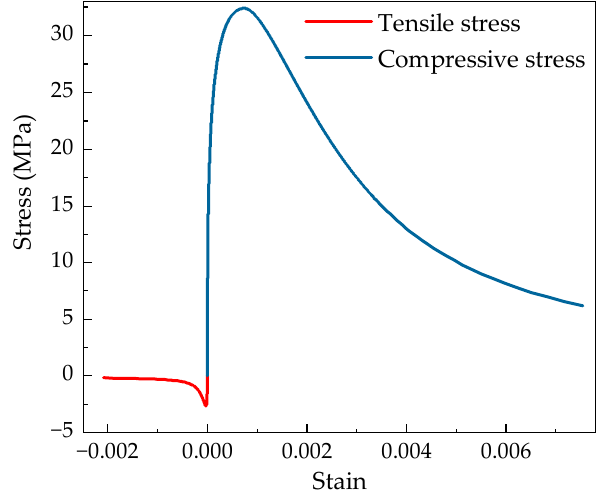
Figure 3. Plastic damage model of C50.